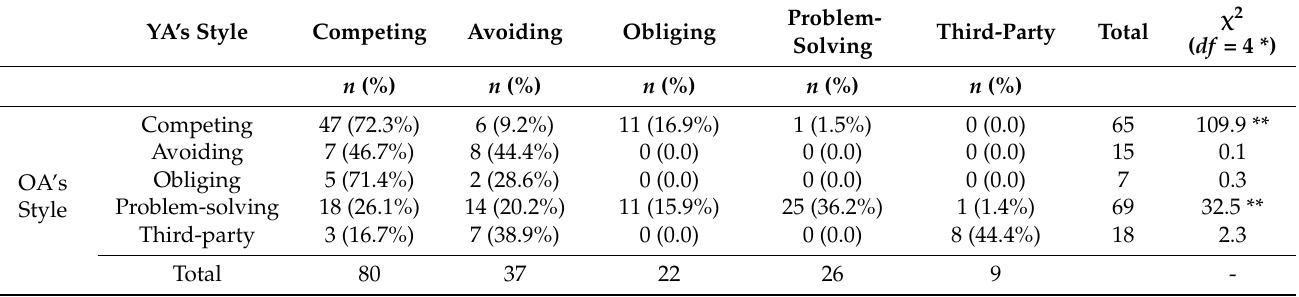
Table 7. Associations between older adult conflict management style and young adult conflict management style in intergenerational